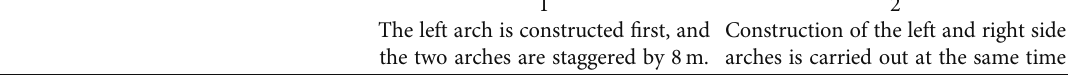
the two arches are staggered by 8